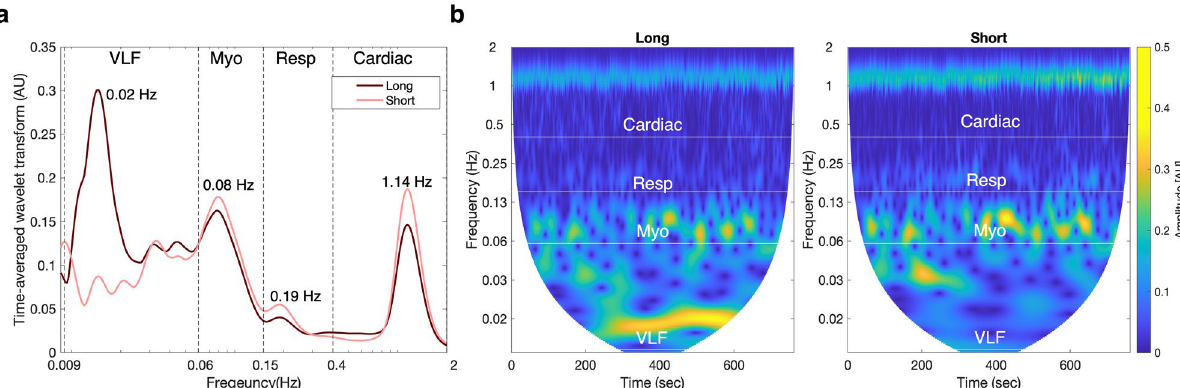
Figure 3. Continuous wavelet transforms of HbO signals from right-middle frontal area of long and short SDS measurements taken during cognitive task for one representative subject. ( a ) Changes in amplitude or absolute value of the wavelet coefficients as a function of frequency. ( b ) Changes in amplitude as a function of time and frequency. Dashed vertical lines in A and horizontal lines in B represent frequency intervals for very low frequency (VLF), myogenic (Myo), respiratory (Resp) and cardiac bands. Figure generated using custom code in Matlab (MathWorks,